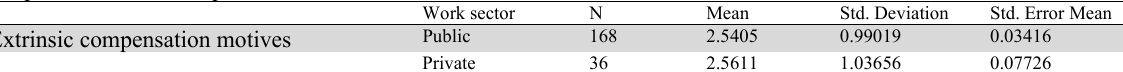
Group Statistics for Compensation Motives